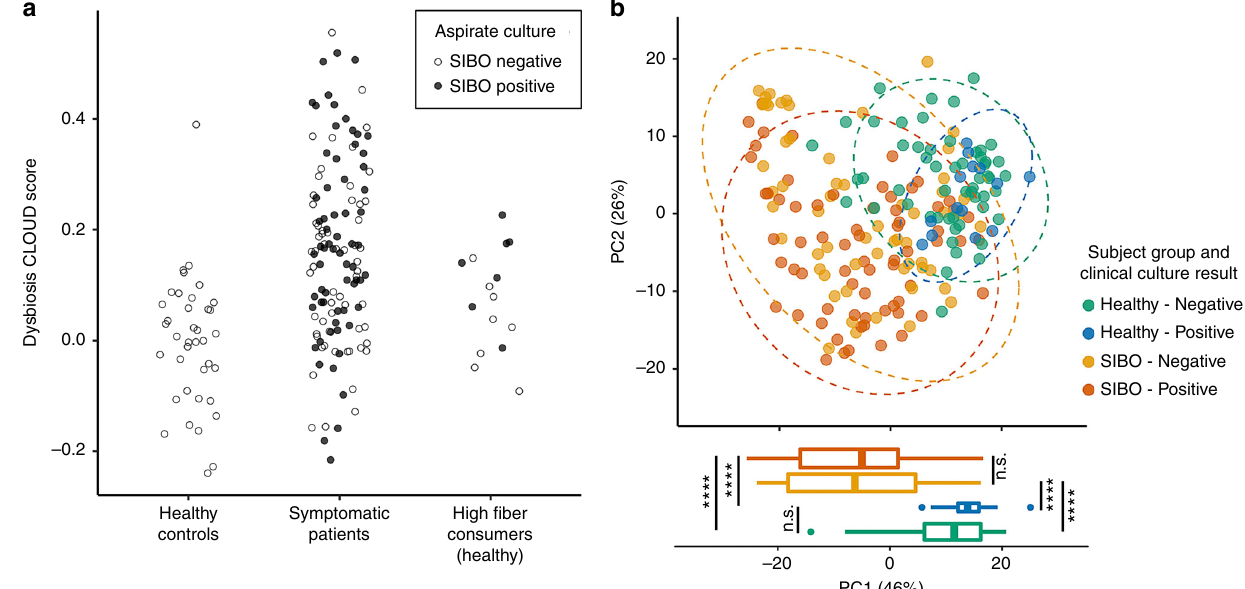
Fig. 5 A subset of healthy individuals consuming high- fi ber diet have SIBO. a DI and b distribution based on Aitchison distance of healthy controls without SIBO (green), symptomatic patients with (red) and without (orange) SIBO, and healthy individuals consuming a high fi ber diet with (blue) and without (green) SIBO. ****, q < 0.0001; n.s., q > 0.05; pairwise t- test with FDR